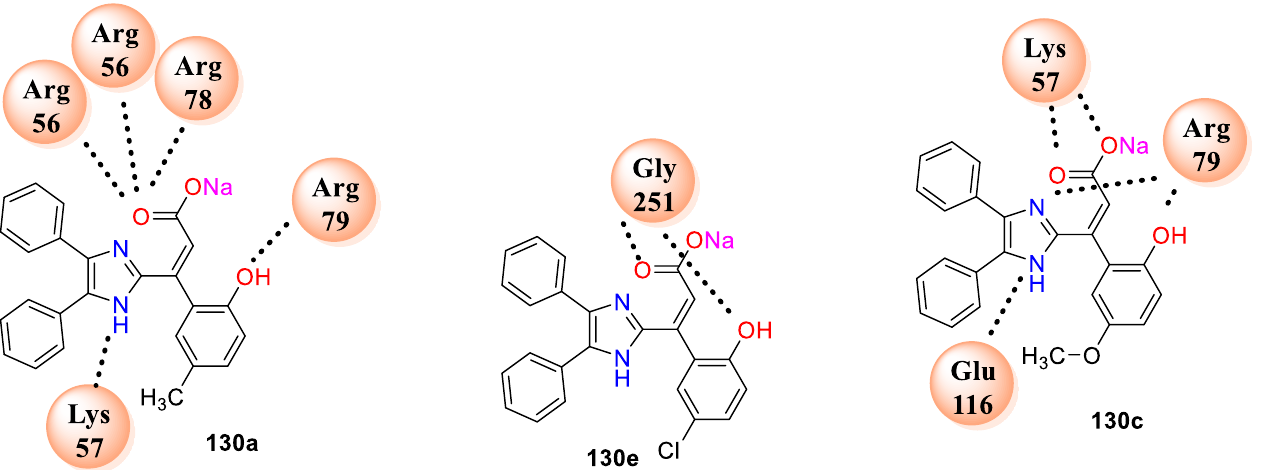
Figure 9. Hydrogen bonding interactions of compounds 130a and 130c with 1AI9 and 130c with N-myristoyl transferase (PDB ID: 4CAW).